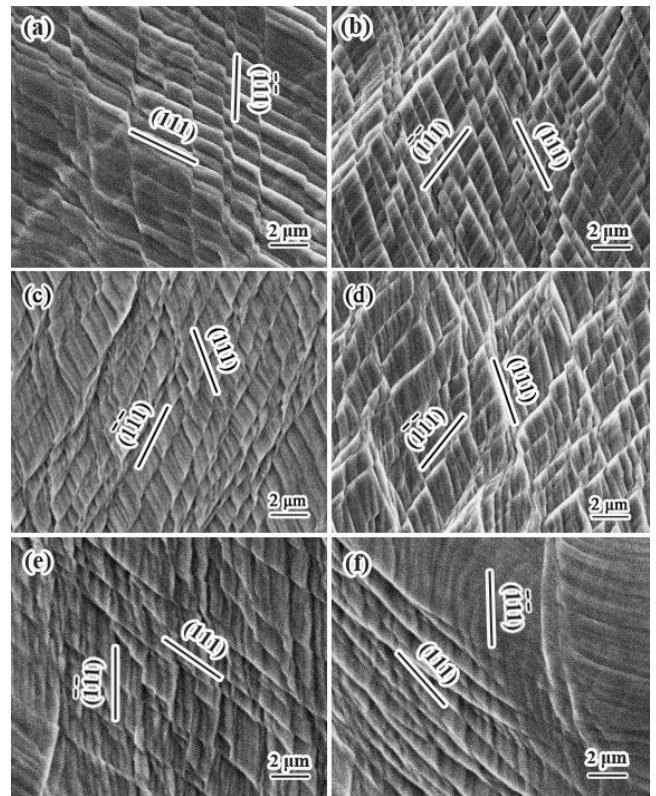
Figure 3. SEM images of the surface deformation features of unfatigued or pre-fatigued [ 233 ] Cu single crystals under uniaxial compression: ( a ) unfatigued, ( b – f ) pre-fatigued at γ pl = 1.3 × 10 − 4 , 3.4 × 10 − 4 , 9.2 × 10 − 4 , 3.5 × 10 − 3 , and 5.3 × 10 − 3 , respectively. ( a , e , f ) viewed from ( 6 9 13 ) ; and ( b – d ) viewed from (320). Note that the loading direction is horizontal.